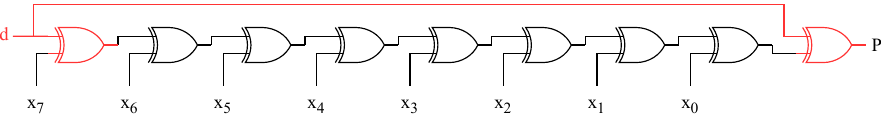
Figure 9: Modified implementation of the serial XOR stage with a dummy